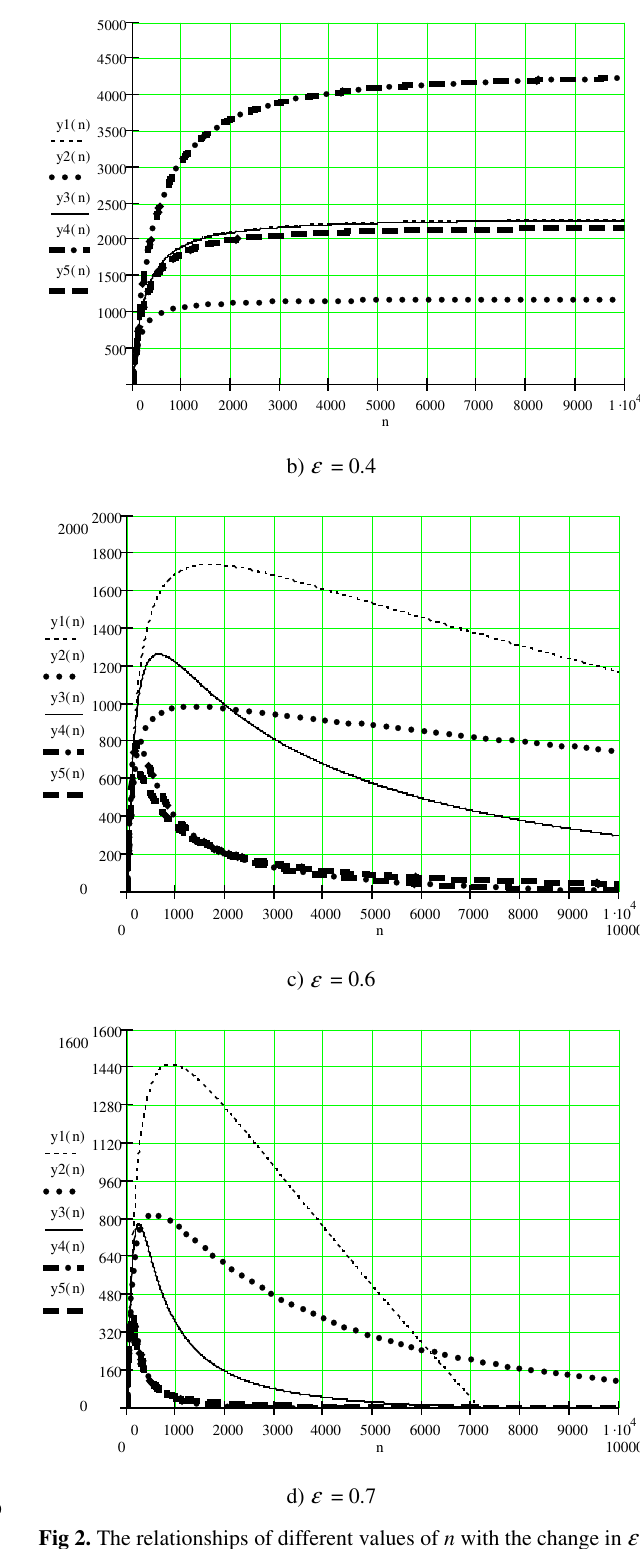
Fig 2. The relationships of different values of n with the change in